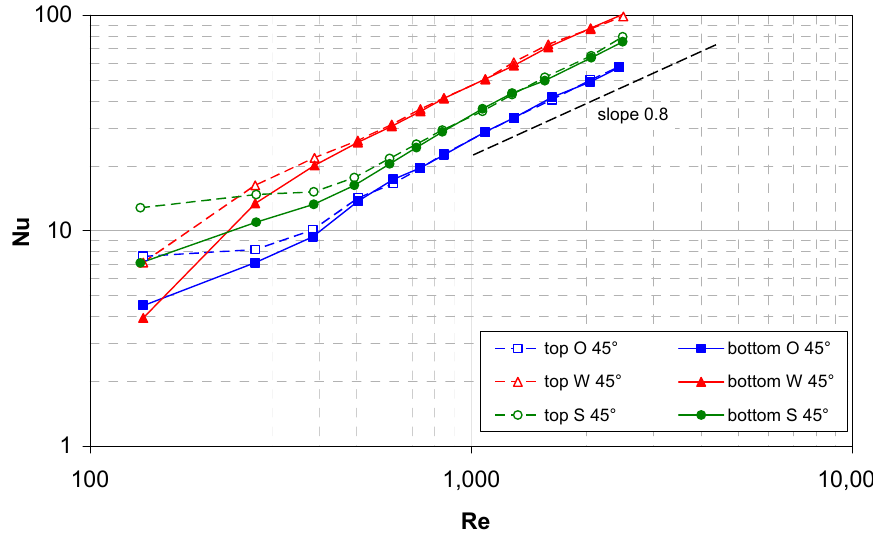
Figure 7. Experimental mean Nusselt number on the top and bottom walls as a function of the Reynolds number for a flow attack angle of 45° and the three spacer geometries investigated.